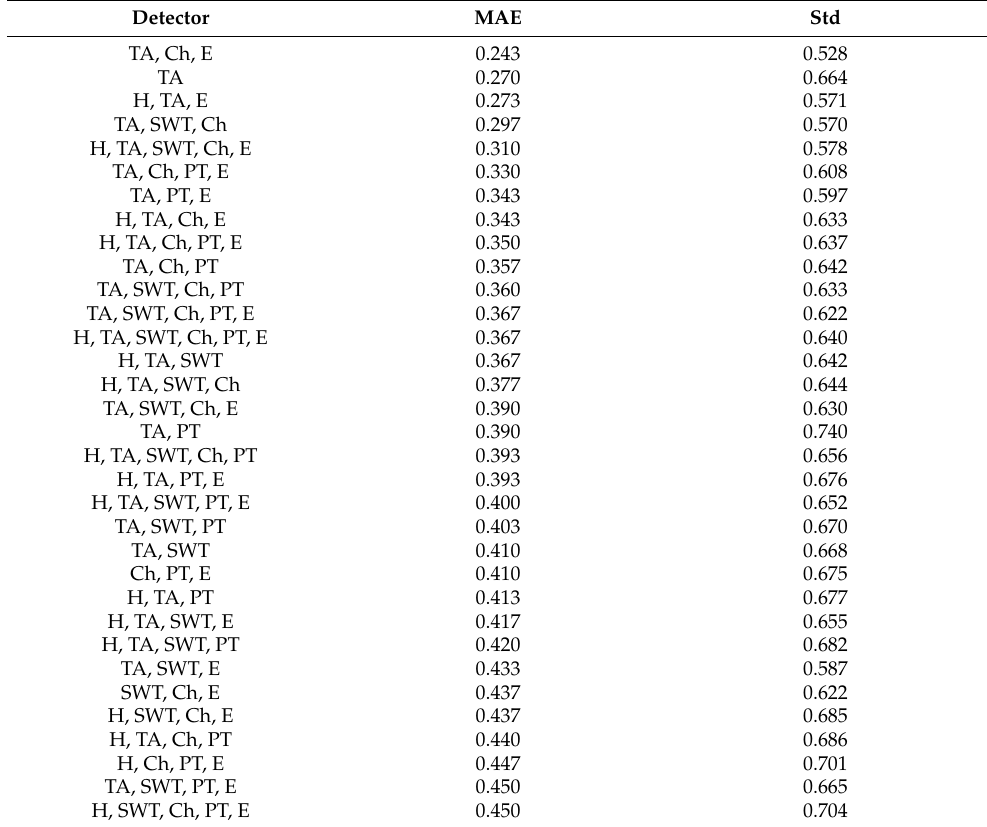
Table A2. R-peak determination Accuracy results using detector combinations for 12-leads